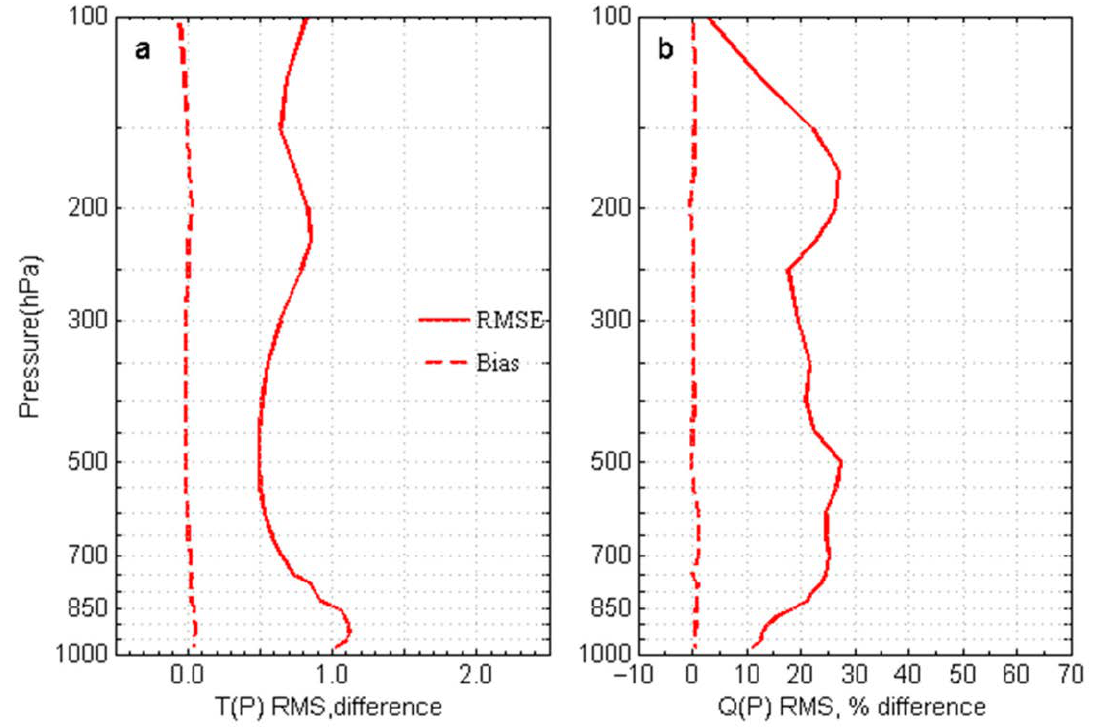
Figure 15. The RMSE and bias of the temperature ( a ) and relative humidity ( b ) profiles between the retrieval results and ERA5 data when the ERA5 data were used as the first